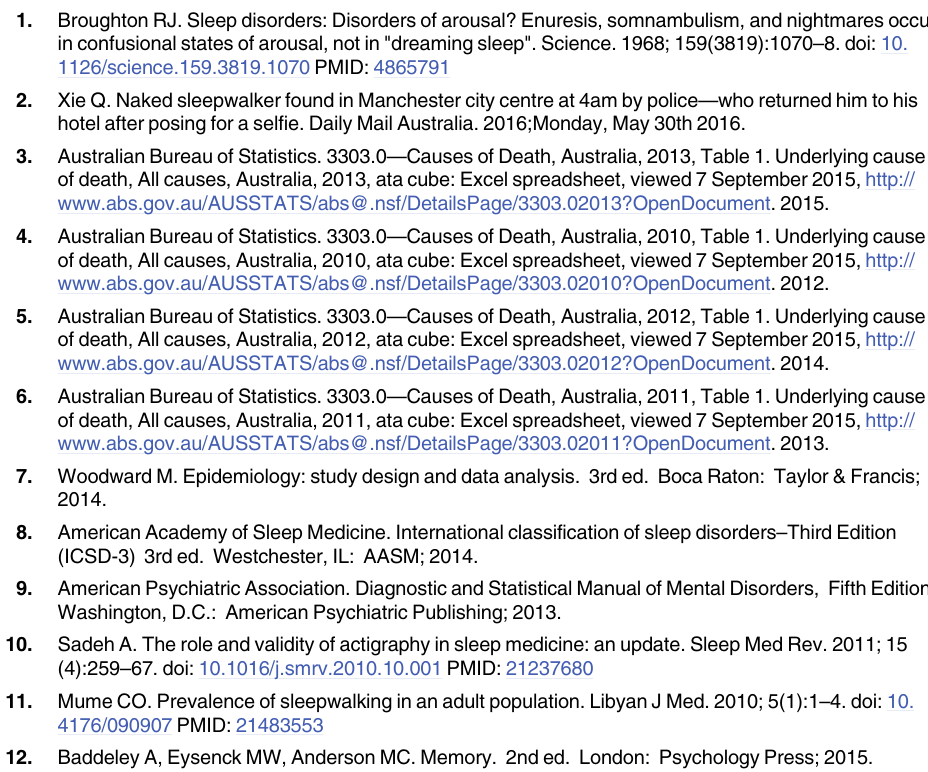
S1 Table. PRISMA